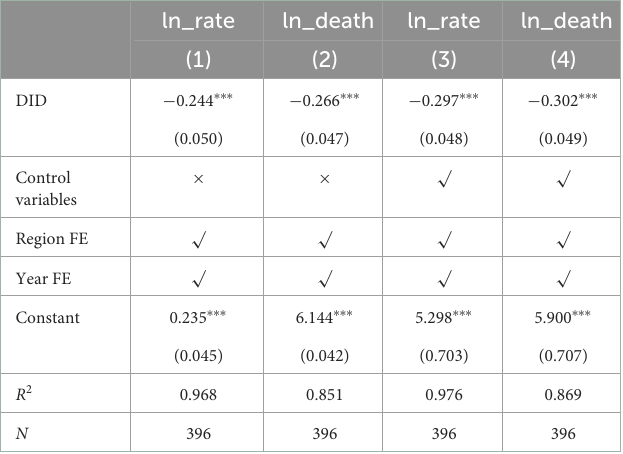
TABLE 6 Results of PSM–DID